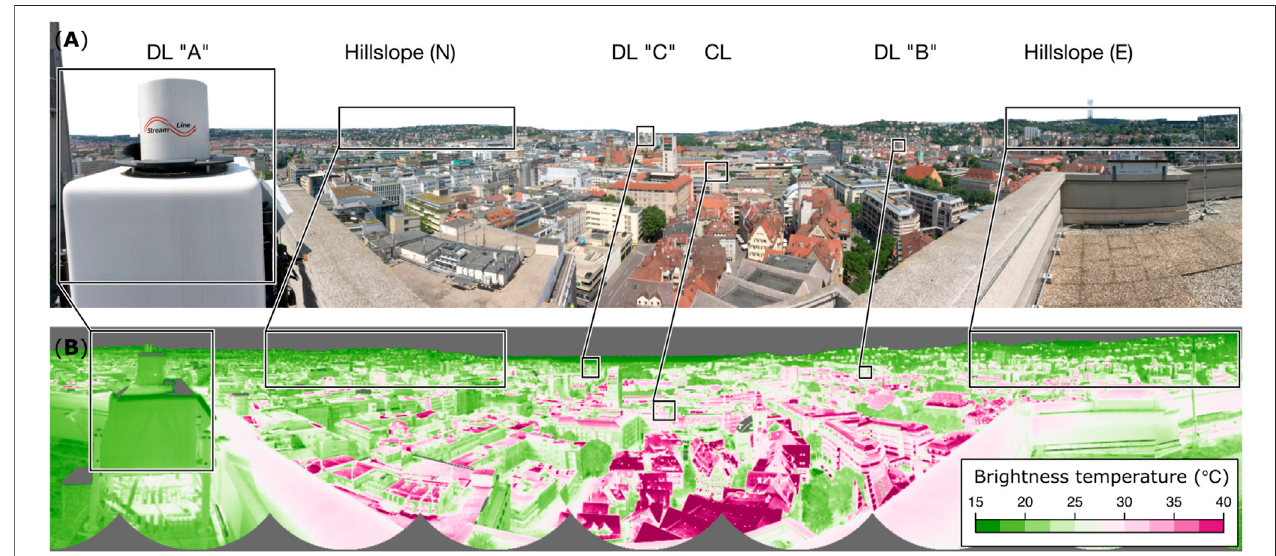
FIGURE 2 | View from the roof-top location of Doppler lidar (DL) unit “ A ” towards DL “ B ” and DL “ C, ” the ceilometer (CL) and hillslopes in approximately Northern and Eastern direction, shown as (A) a digital camera still image and (B) a composite of thermal infrared images.